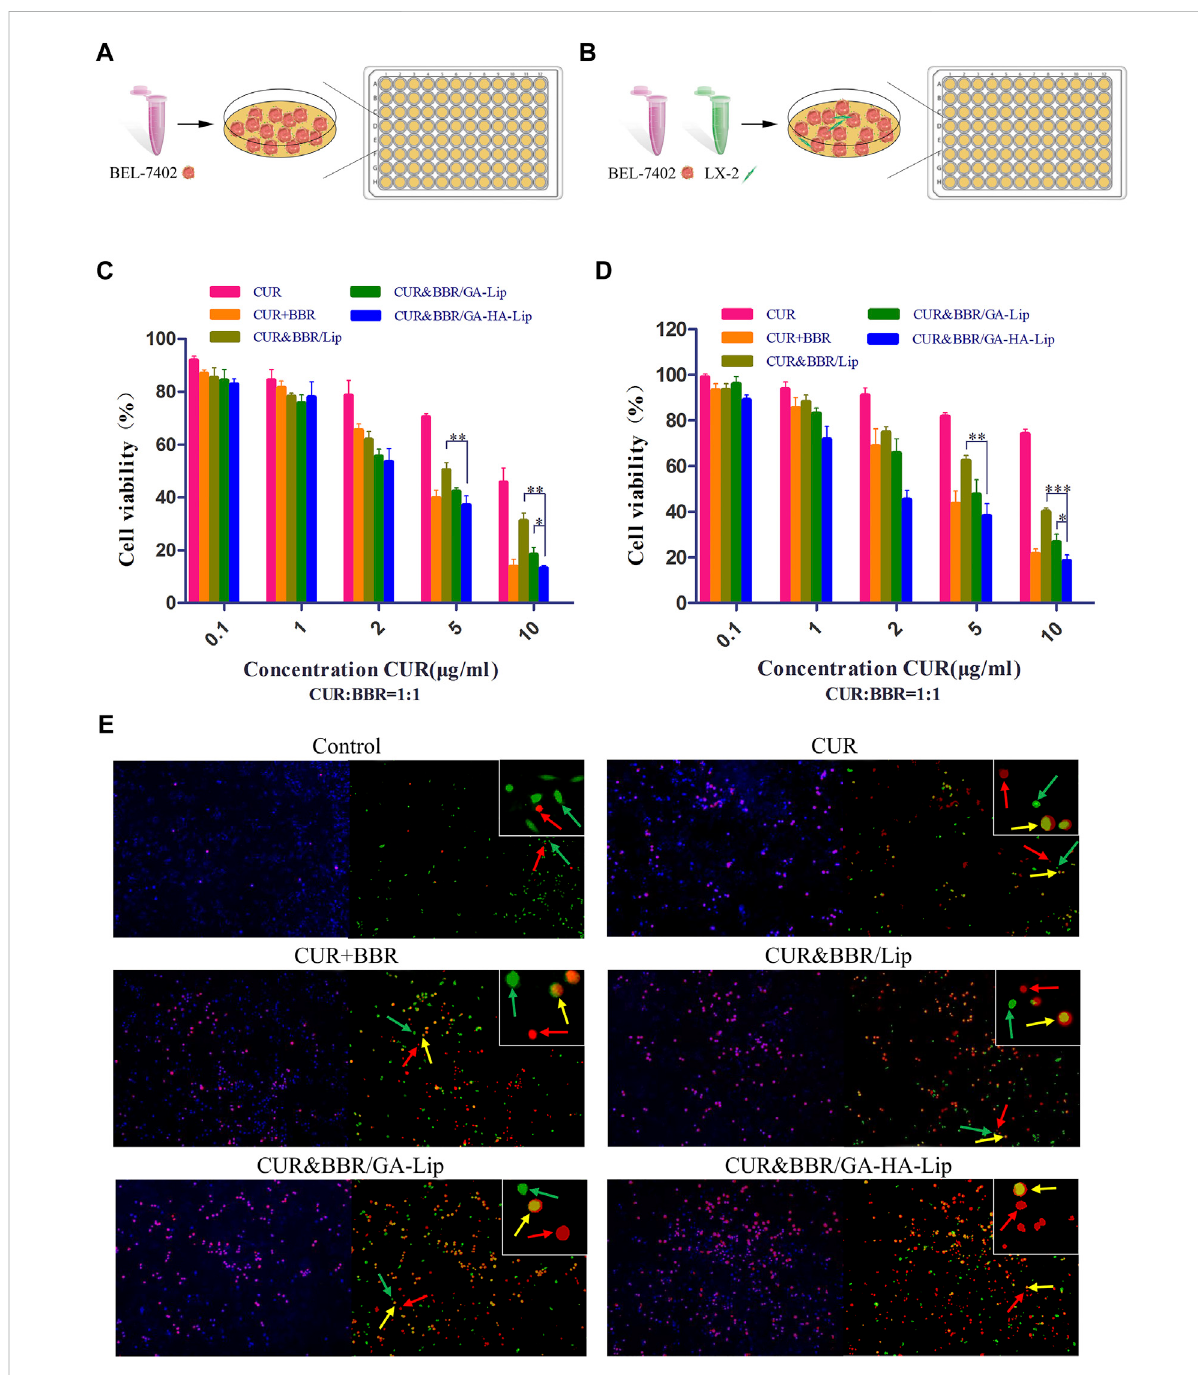
FIGURE 4 In vitro cytotoxicity analysis. Invitro researchmodel ofBEL-7402cells (A) and BEL-7402+LX-2 co-cultured system (B) . Cytotoxicity ofdifferent drug formulations against BEL-7402 cells (C) and BEL-7402+LX-2 co-cultured system (D) . (E) Live/dead staining assay against co-cultured system. Green fl uorescence: live LX-2 cells; red fl uorescence: dead BEL-7402 cells; yellow fl uorescence: dead LX-2